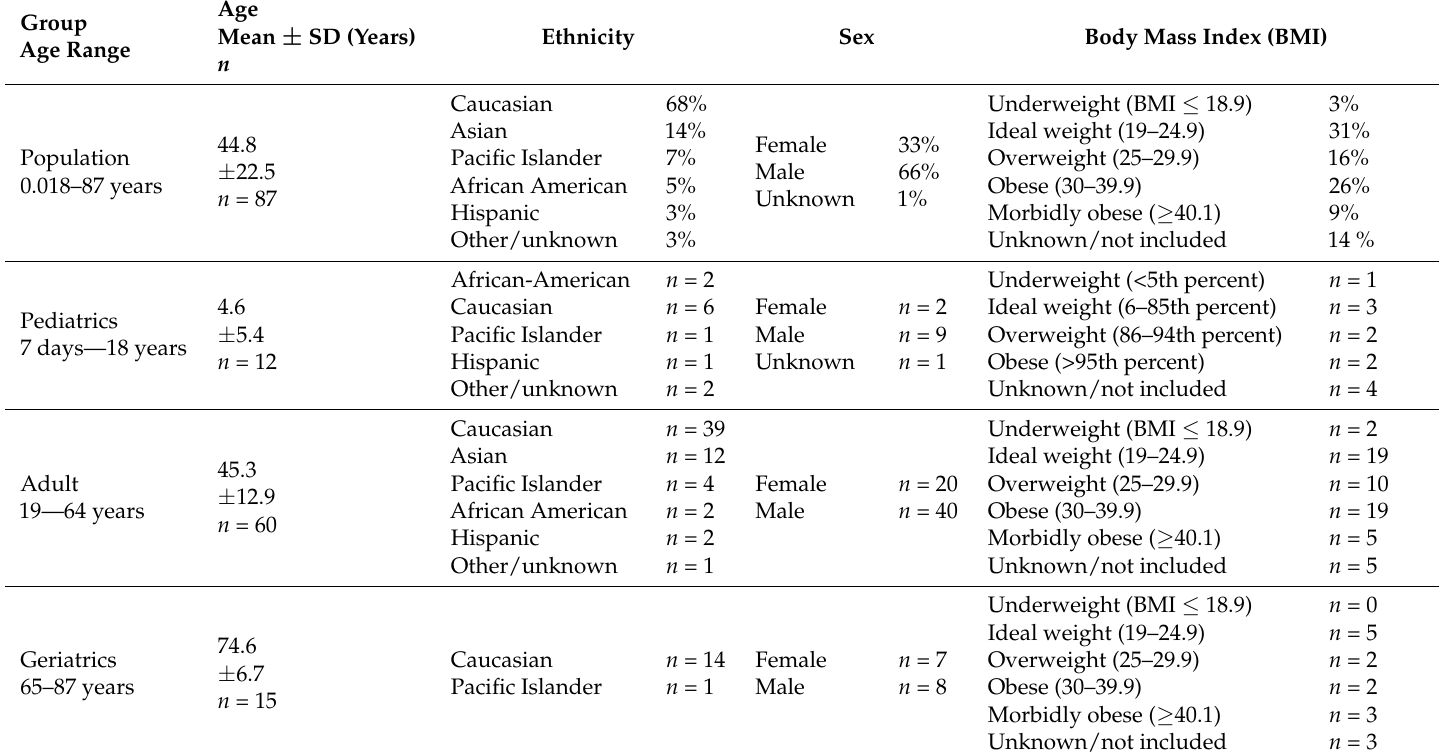
Table 2. Demographic information of the liver